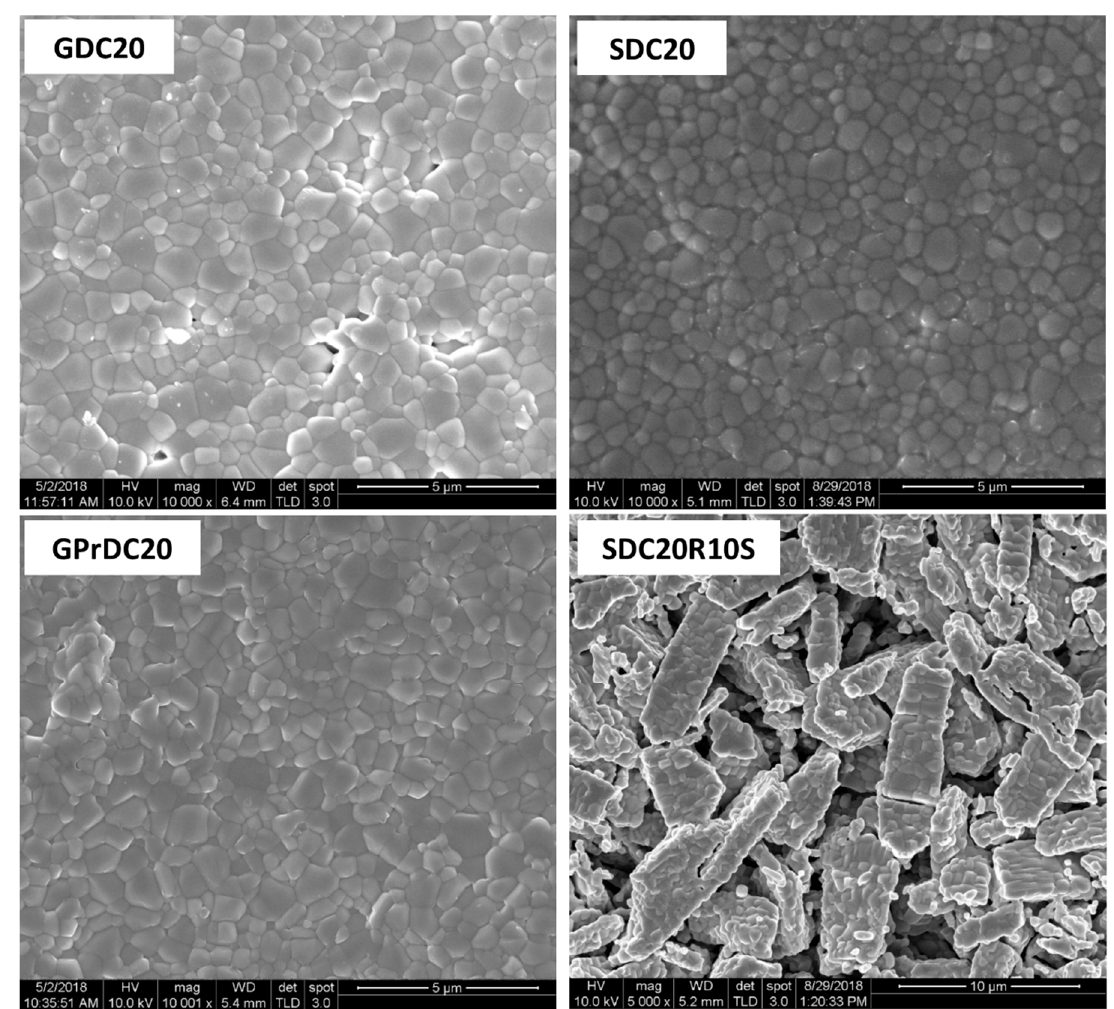
Figure 8. SEM micrographs of some sintered pellets: GDC20, SDC20, GPrDC20, and